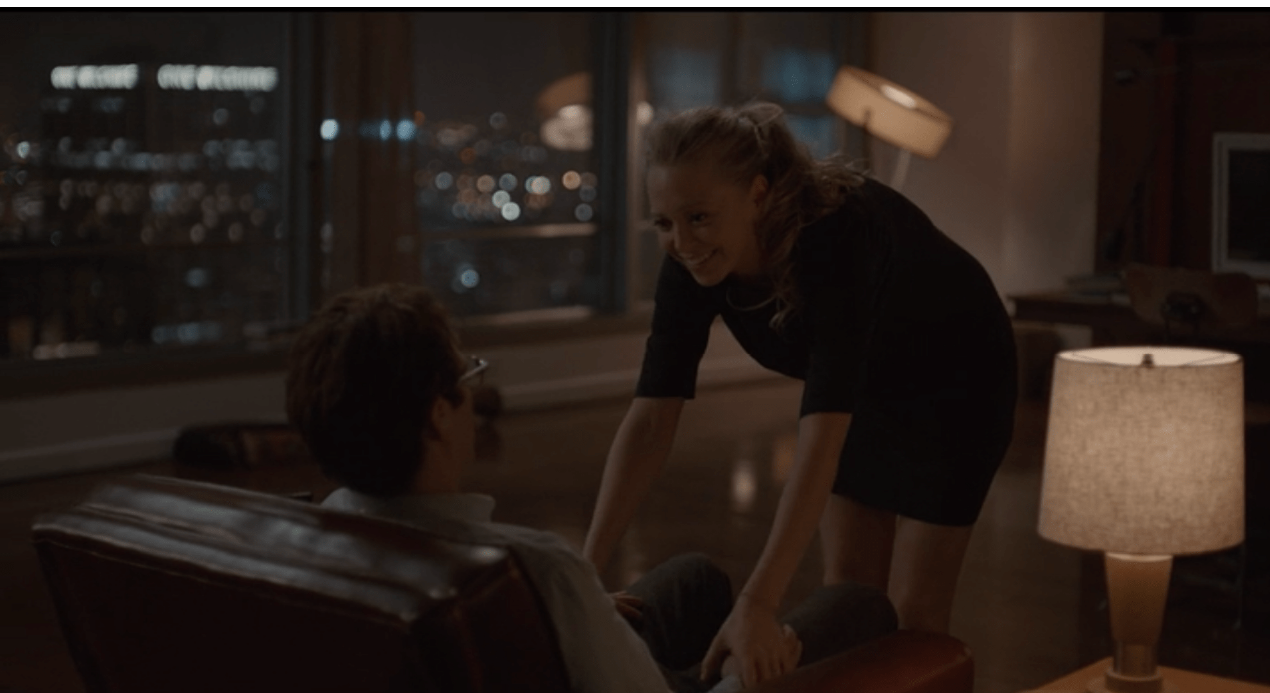
Figure 6. “Just play with me!” Samantha begs Theo, as she directs Isabella, a sex surrogate. (Screenshot created by